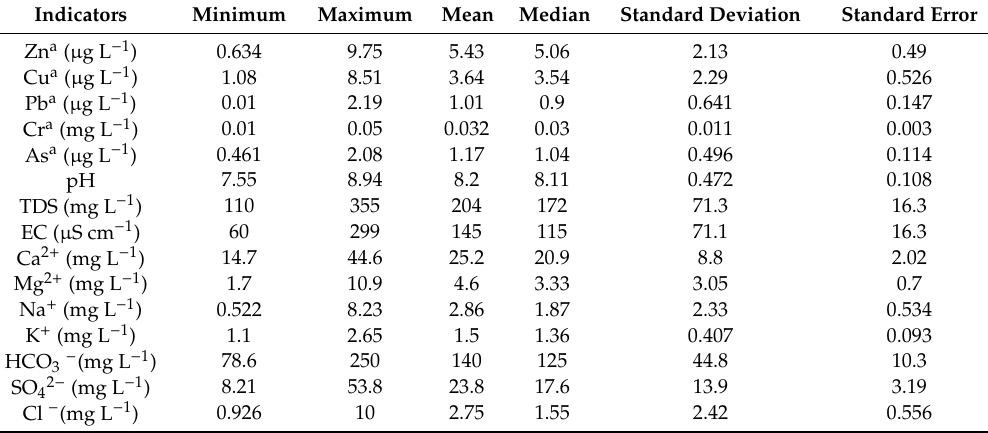
Table 2. Environmental indicators of river water in the Issyk − Kul Basin during the period with low river flow (L, n = 19 ).